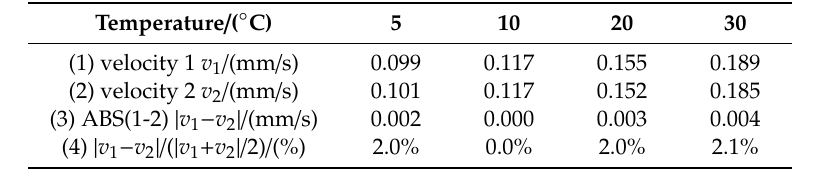
Table 2. Bulk settling velocity of di ff erent methods (velocity 1 v 1 is derived from H and t 1 / 2 ; velocity 2 v 2 is the statistical result of all particles and flocs at water depths from 4.0 mm to 5.0 mm; ABS(1-2) | v | means the absolute di ff erence between velocity 1 and velocity 2; | v − v 1 2 the relative di ff erence between velocity 1 and velocity 2).